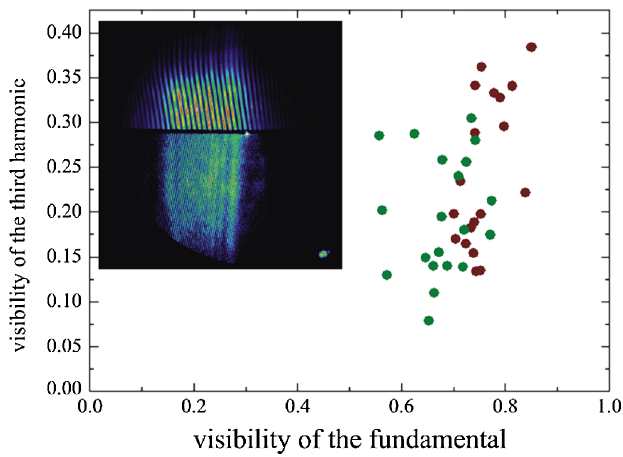
FIG. 12. Correlation between 24 nm fundamental wavelength and the third harmonic radiation. The inset shows interference fringes simultaneously measured for 24 nm (upper) and 8 nm (lower) by means of Al = Zr filters. Green dots are taken at (cid:1) t ¼ þ 2 : 5 fs , red dots at (cid:1) t ¼ (cid:3) 1 : 5 fs .